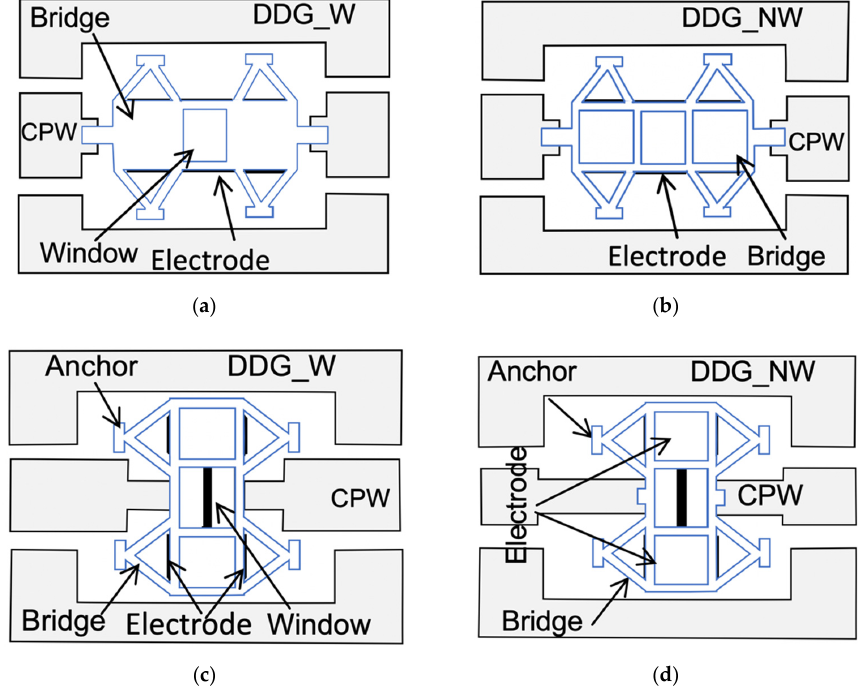
Figure 2. RF-MEMS switch membrane configurations and actuation electrodes for the DDG sus- pension. ( a ) DDG-W, in-line, ( b ) DDG-NW, in-line, ( c ) DDG-W, 90 ◦ -rotated, and ( d ) DDG-NW, 90 ◦